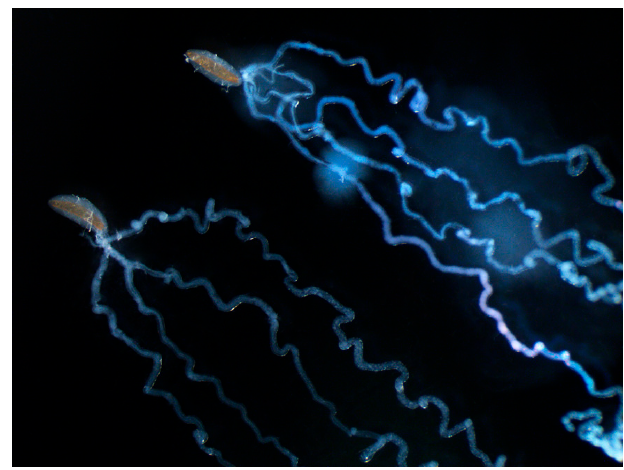
Figure 4. Diachasmimorpha longicaudata venom glands with abundant entomopox virus (DlEVP) in their lumens, and escape of virions into surrounding medium from puncture of lower filament in upper right venom apparatus. (Source: courtesy of Kelsey Anne Coffman, Univerity of Georgia, Athens, GA, USA). Unlike viruses, VLPs do not contain encapsulated RNA or DNA but this is not that